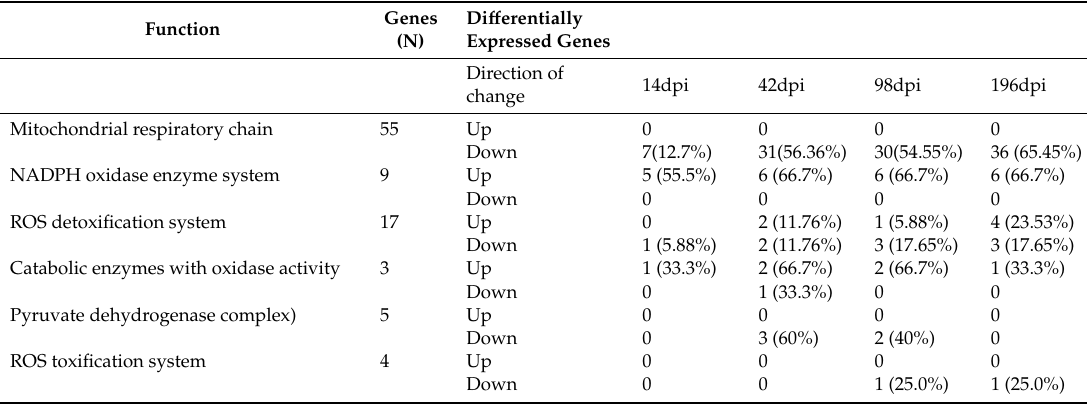
Table 2. Di ff erential expression of manually selected genes functionally associated with the generation and detoxification of ROS in